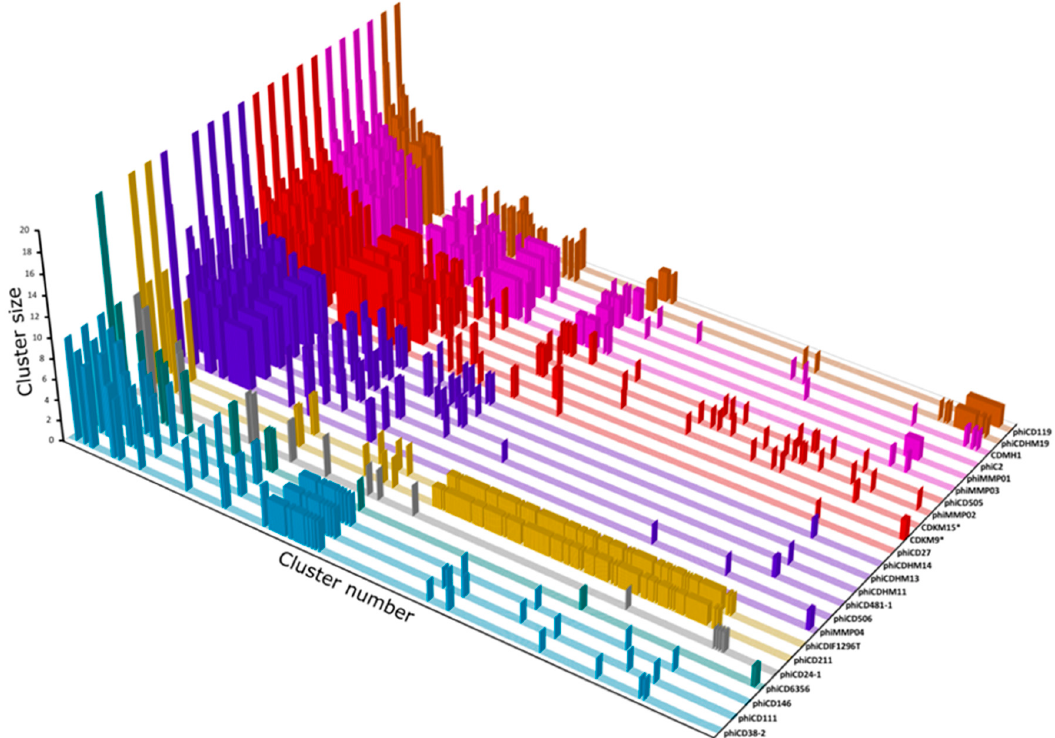
Figure 9. Plot of protein clusters shared by the 24 C. difficile phages. The y ‐ axis represents the cluster size (number of phages encoding homologues) and clusters are arranged along the x ‐ axis by size. Colouring is consistent with Figure 6.